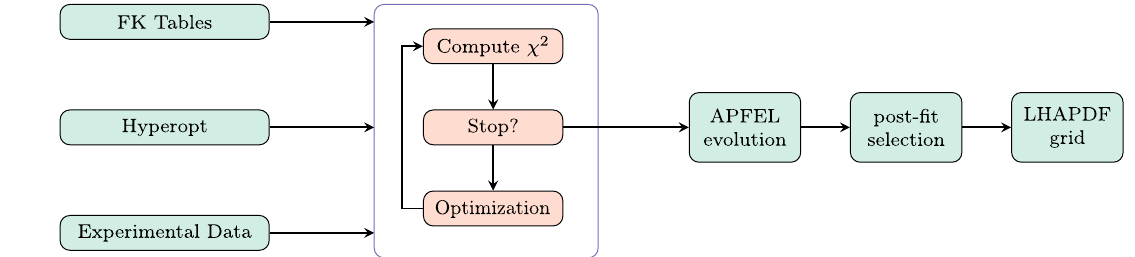
Fig. 3 Diagrammatic representation of the NNPDF fitting framework. The blue box contains the minimization of the χ 2 figure of merit, whose computation is illustrated in Fig. 4